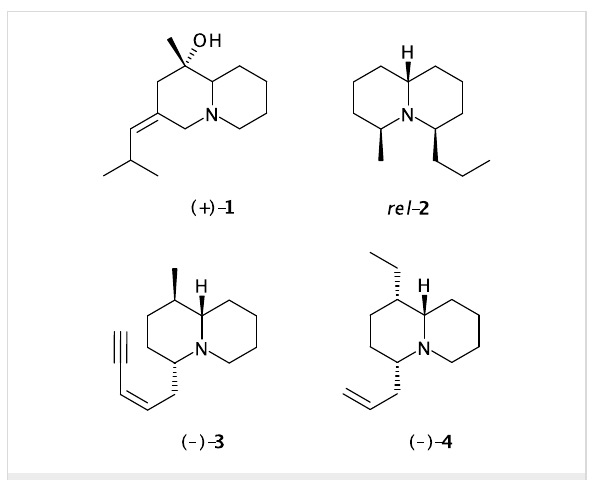
Figure 1: Representative quinolizidine alkaloids from amphibians.